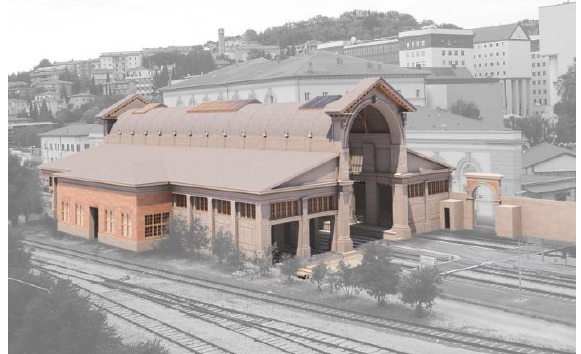
Figure 2. Comparison between the built station and the project station